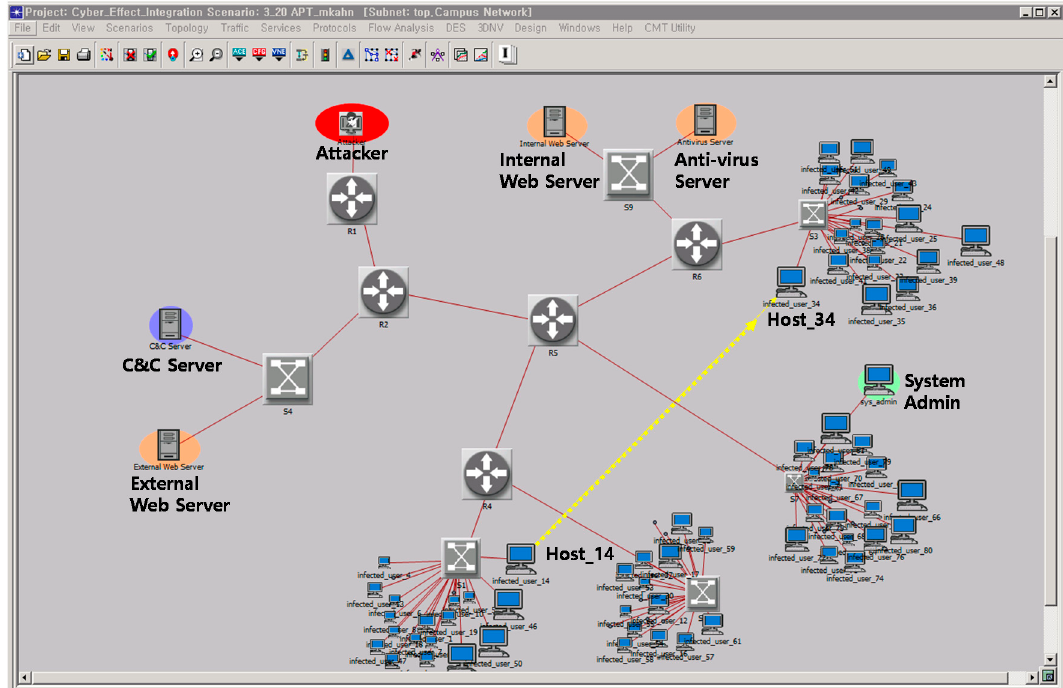
Figure 7. Network topology for cyber risk simulation and combat experiment analysis.